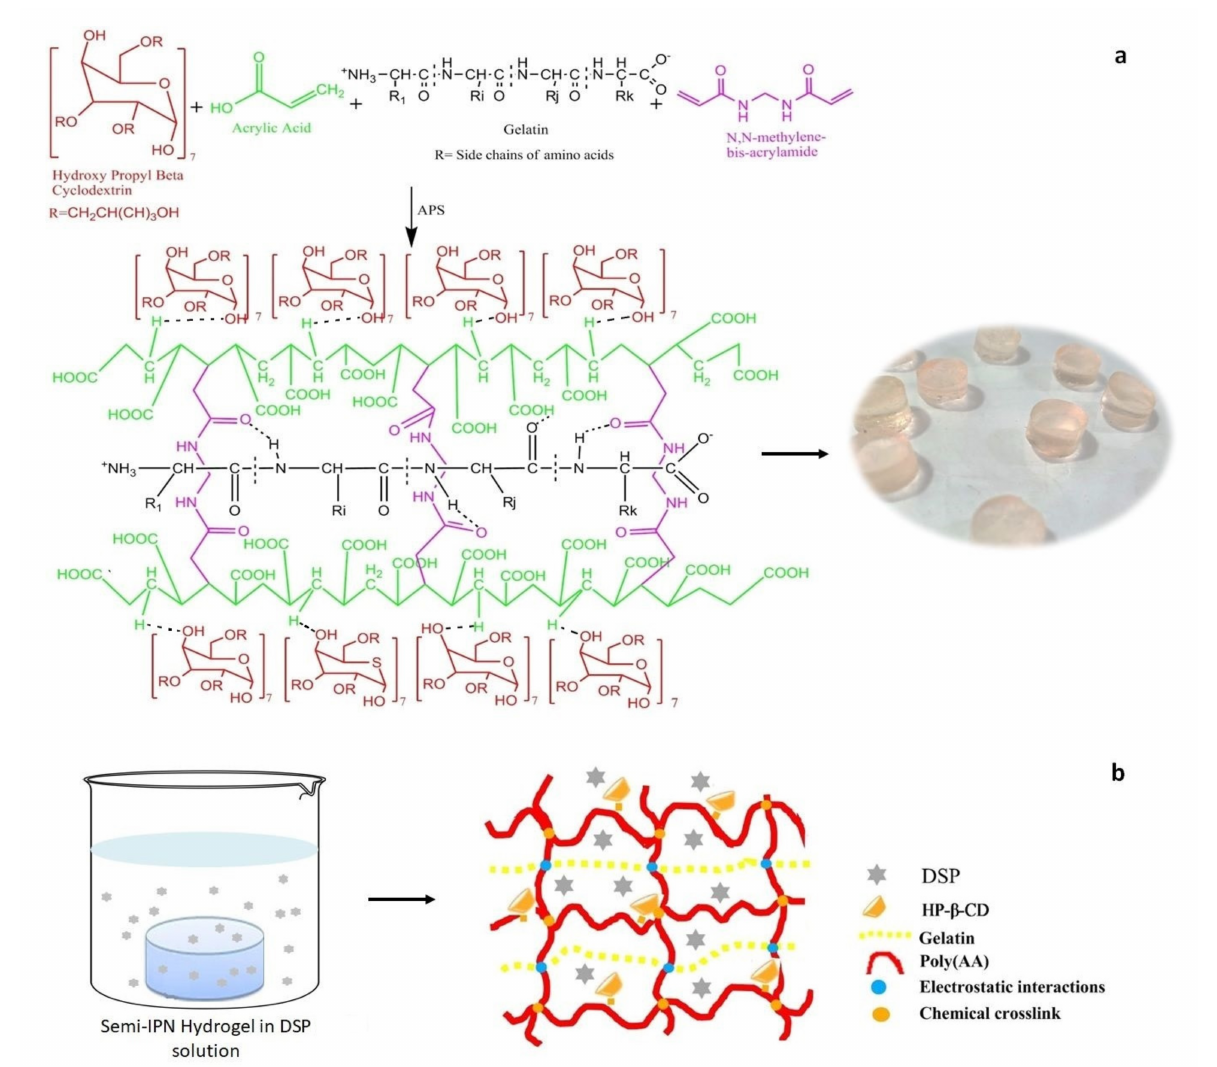
Figure 1. ( a ) Chemical structures of polymers, monomer, and cross-linker. Possible cross-linked structure and appearance of DSP-loaded HP- β -CD-g-poly(AA)/gelatin semi-IPN hydrogels. ( b ) DSP loading in semi-IPN